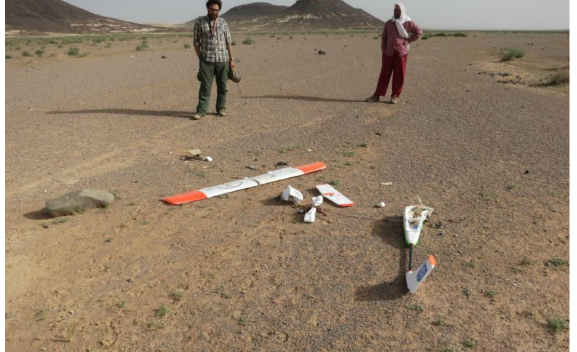
Figure 6. The results of a crash landing of the fixed-wing drone. Repaired by the pilot (Hill), the plane flew again several weeks